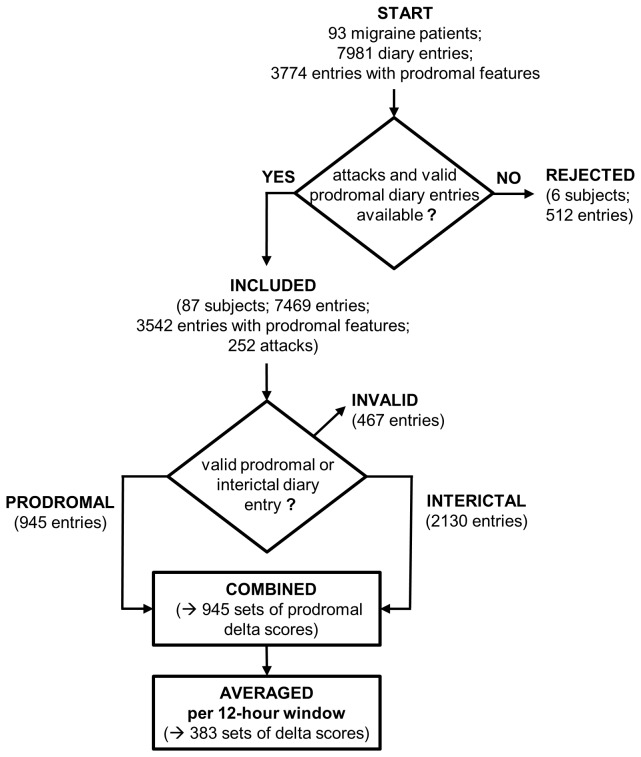
Flow chart for the selection of subjects and diary entries.